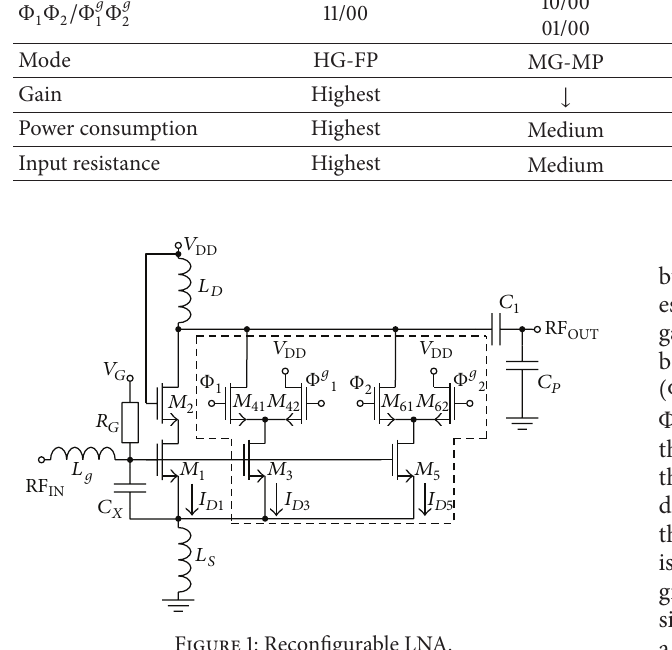
Figure 1: Reconfigurable